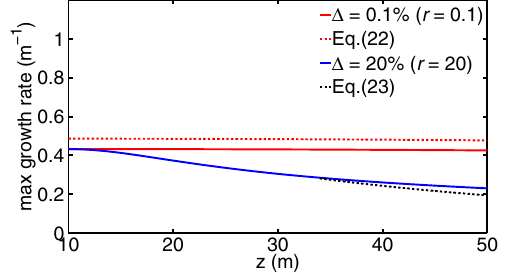
FIG. 2. Sideband growth rate as a function of z for two cases: the gentle and strong undulator tapering. The red solid line refers to the gentle tapering and is obtained by numerically solving Eq. (20) and taking the maximum value from the dispersion curve at each z location; the red dotted line is calculated from Eq. (22) for Δ ¼ 0 . 1% . The blue solid and black dotted lines refer to the strong tapering, in which the former is obtained from Eq. (20) and the latter from Eq. (23). In the black dotted line, Ξ ≈ 4 . 7 at ð 0 Þ j ≈ 2 . 52 . z ≈ 50 m. Here ρ ≈ 1 . 57 × 10 − 3 and j E 0